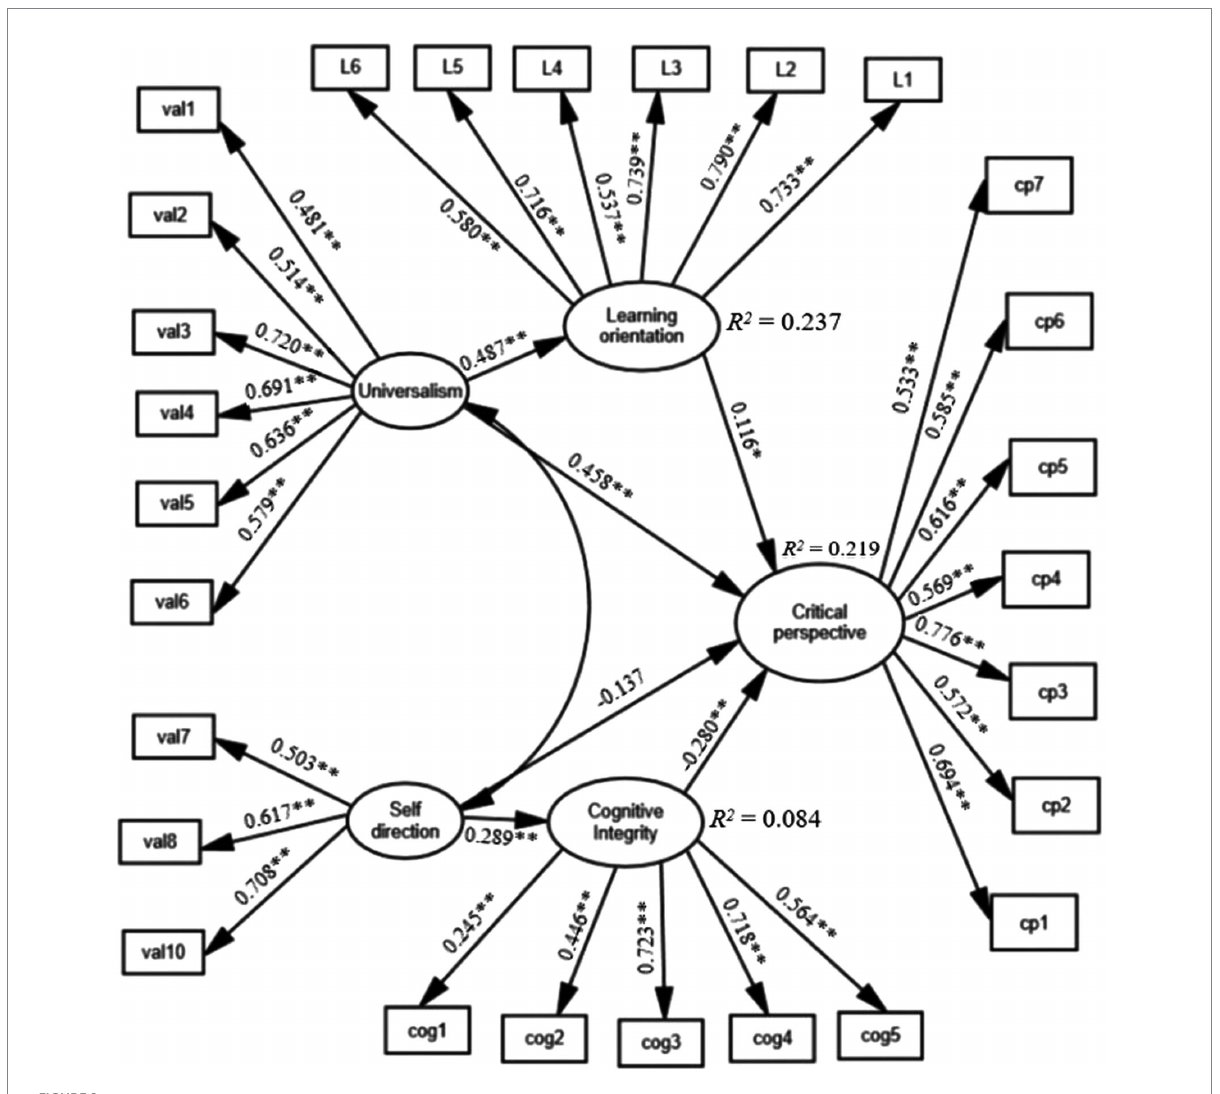
FIGURE 2 The structural equation model. All coefficients are standardized. * p <0.05, ** p